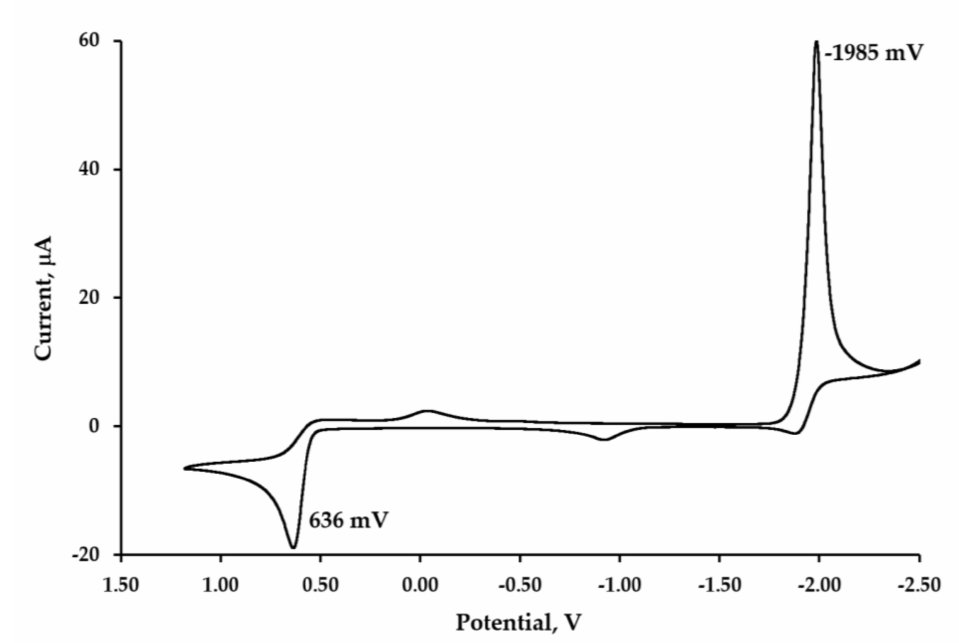
Figure 4. Cyclic voltammogram of ca. 0.02 M solution of 2 in 0.1 M [ n Bu 4 N][PF 6 ]/CH 2 Cl 2 vs. external Cp 2 Fe/Cp 2 Fe + at 25 ◦ C. Scan rate = 100